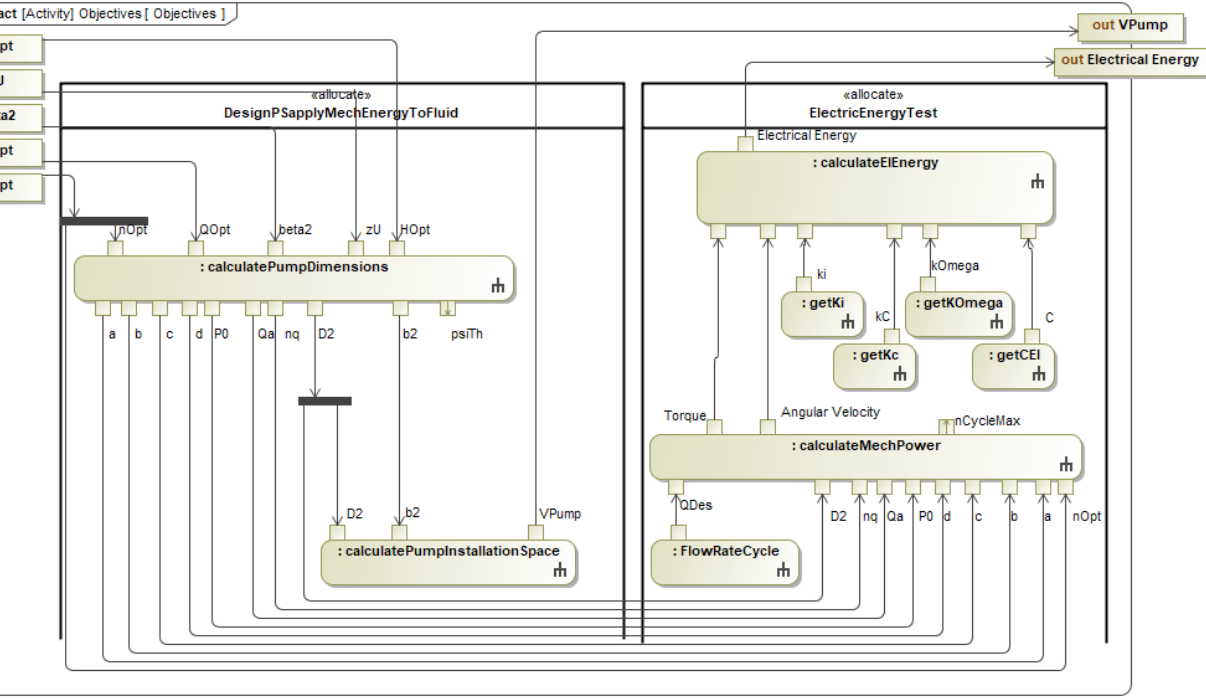
Figure 12. Calculation of objectives. Definition of design variables at the top left and objectives at the top right.